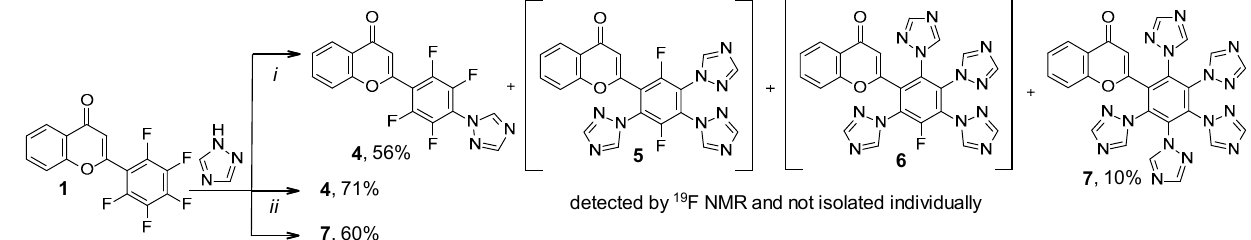
detected by 19 F NMR and not isolated individually